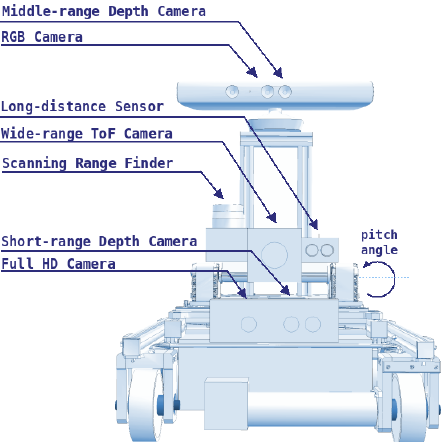
Figure 3. Sensors for perception of the environment previously attached to AIR1. Depth cameras and Lidar sensors were used to map the tanks and to predict the sizes of spherical pressure vessels (adapted from